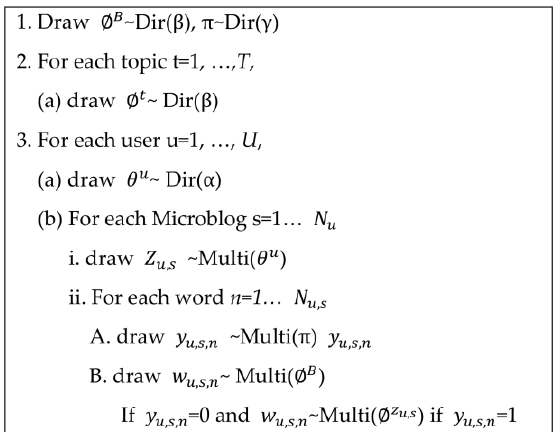
Figure 4. Generation process of Microblogs